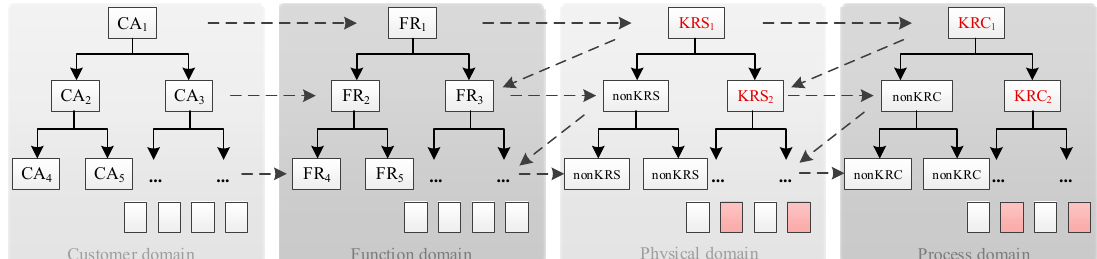
Figure 3. Key reliability characteristic (KRC) identification structure diagram based on axiomatic domain mapping.